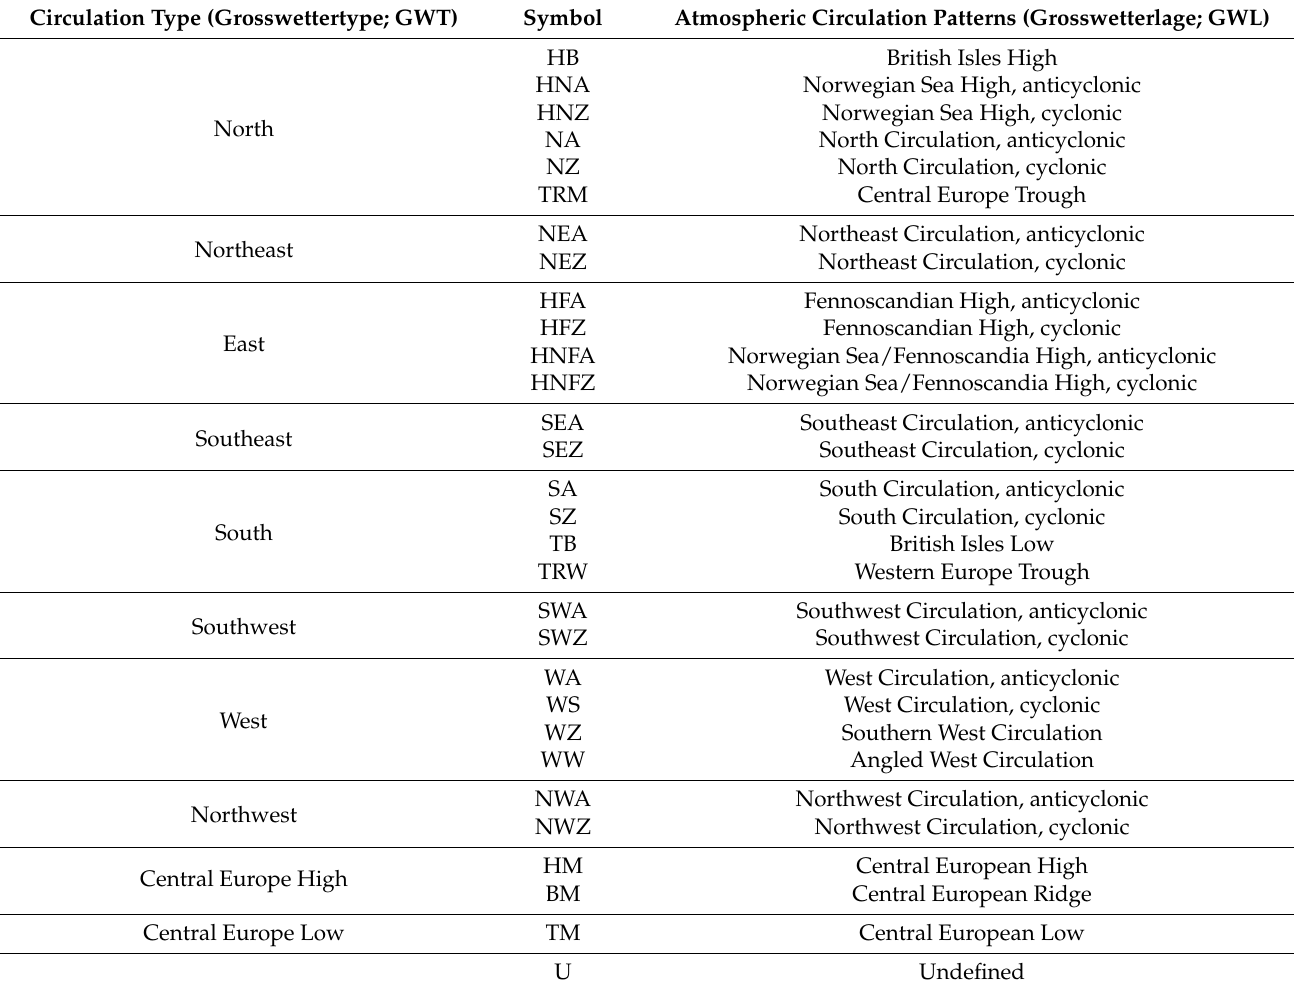
Table 1. Definitions of the circulation types (GWT) and the atmospheric circulation patterns (GWL) [37]. Circulation Type (Grosswettertype; GWT)